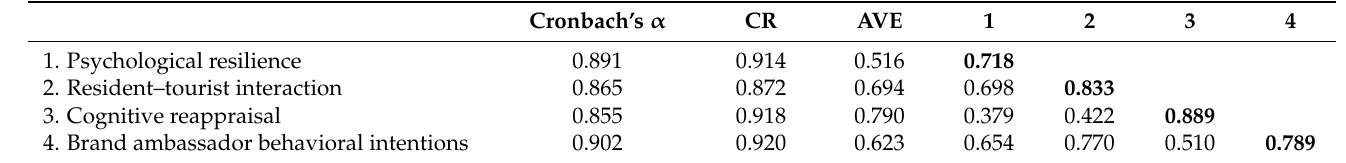
Table 1. CR, AVE, and correlation matrix.